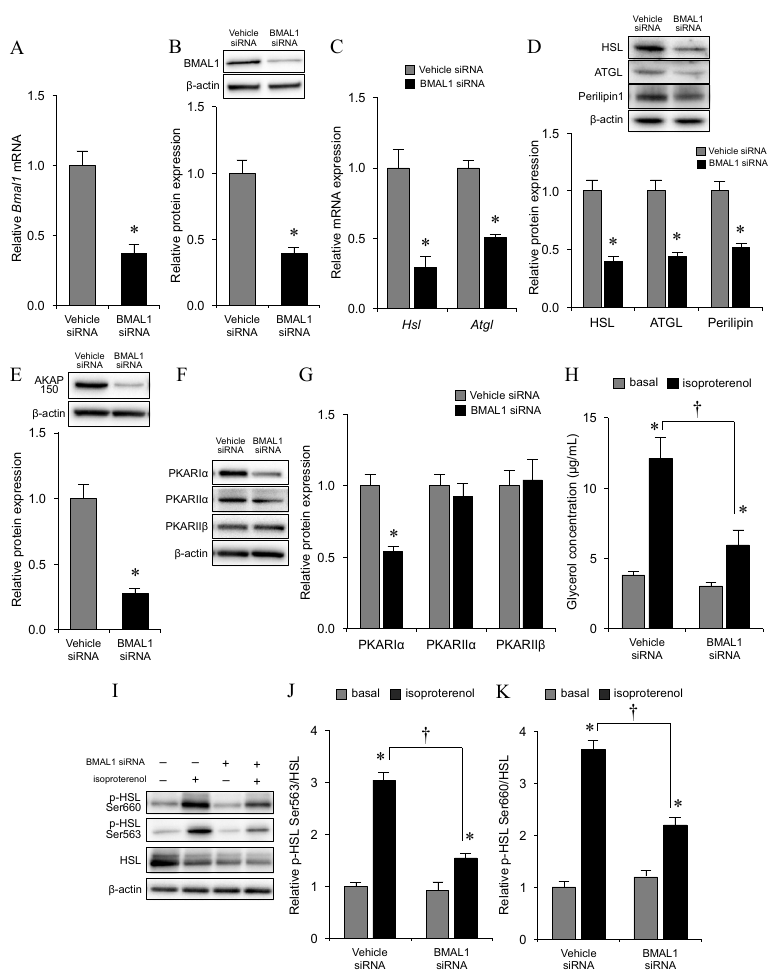
Figure 2. Effect of Bmal1 expression knockdown on adipocyte lipolysis in differentiated 3T3-L1 adipocytes. Differentiated 3T3-L1 adipocytes were transfected with control siRNA or specific siRNA for Bmal1 using a transfection reagent. After 48 h, basal or isoproterenol-stimulated glycerol release was measured, and the cells were harvested for subsequent analysis by quantitative real-time PCR or Western blotting. ( A ) Relative expression levels of Bmal1 mRNA. The mRNA levels were measured by quantitative real-time PCR using specific primers and normalized to the amount of 18S rRNA. ( B ) Representative immunoblotting data (upper panel) and relative densities of BMAL1 protein (bottom